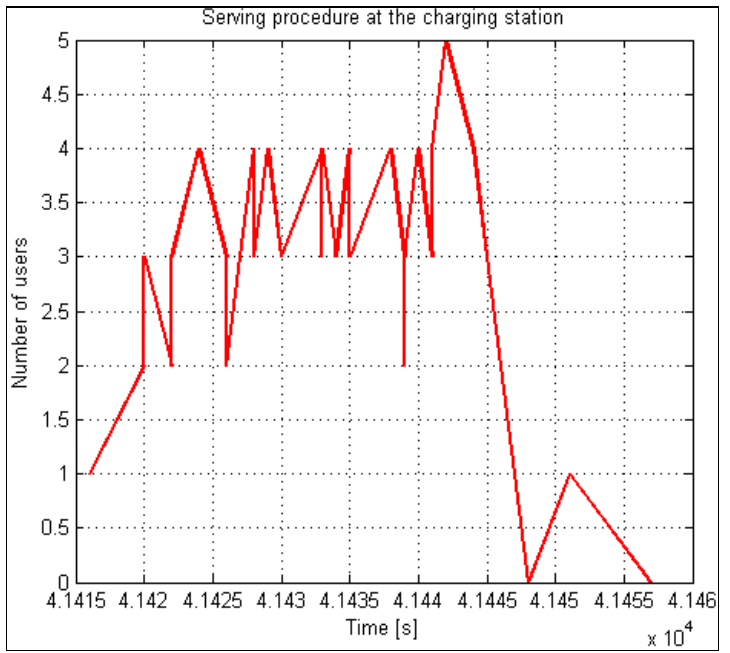
Figure 18. An interim system load pattern when searching for an optimal and exact solution for the considered system.